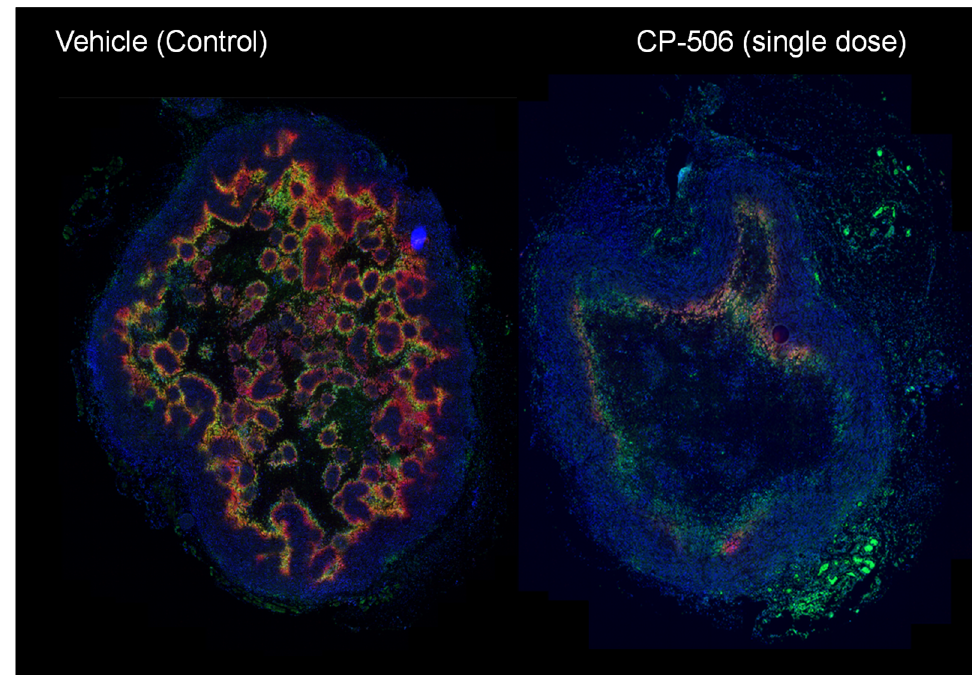
Figure 5. Modification of the hypoxic microenvironment following administration of CP-506 in MDA-MB-468 TNBC tumour-bearing mice. Representative immunohistochemical image showing hypoxic regions in whole tumour cross section (green, pimonidazole, red EF5 binding) before and after (24 h) a single dose of CP-506 (900 mg/kg, intraperitoneal). Nuclei are counterstained (blue, DAPI). Image was provided by Dr Maria Abbattista with permission.